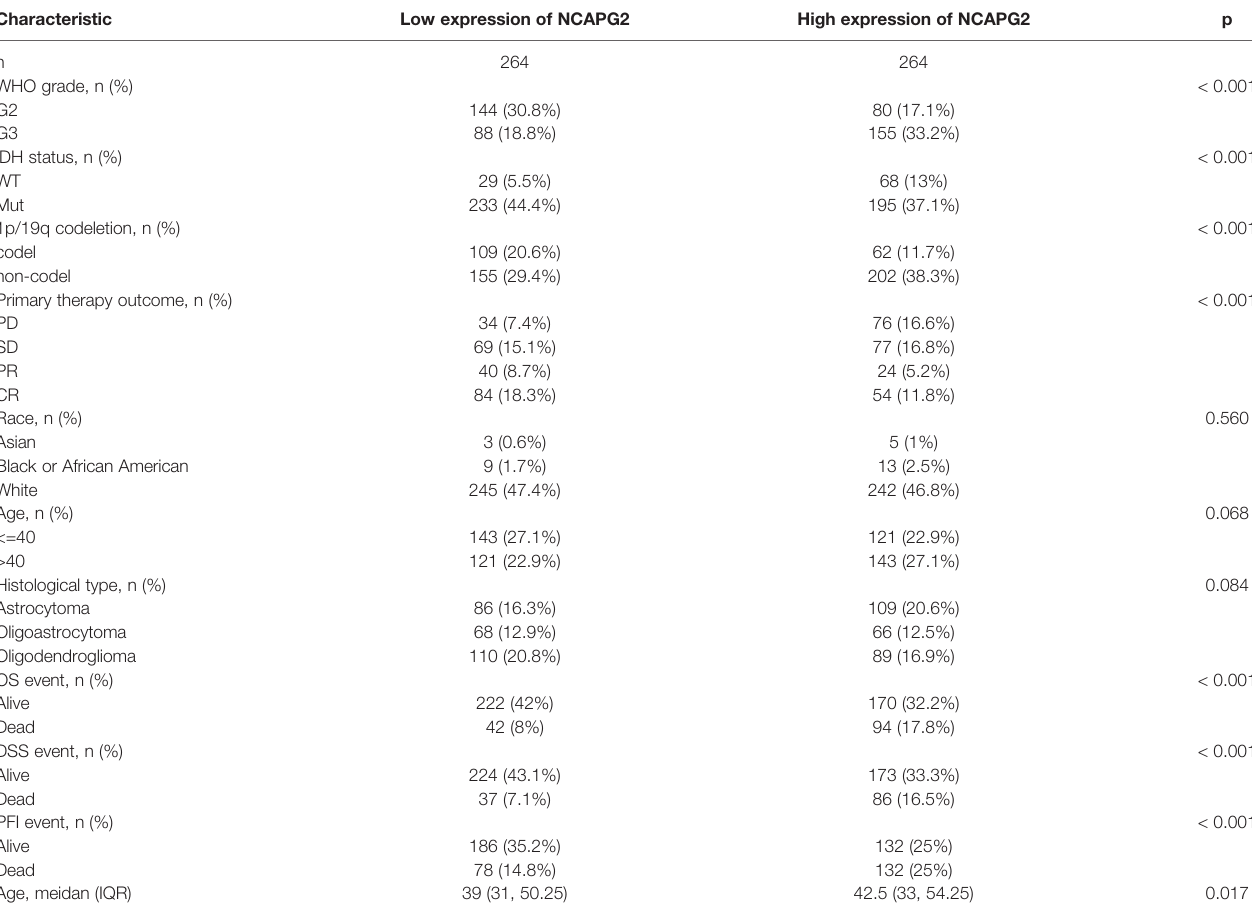
TABLE 1 | Correlation between NCAPG2 and clinic-pathological examined by TCGA-LGG database. Characteristic Low expression of NCAPG2 High expression of NCAPG2